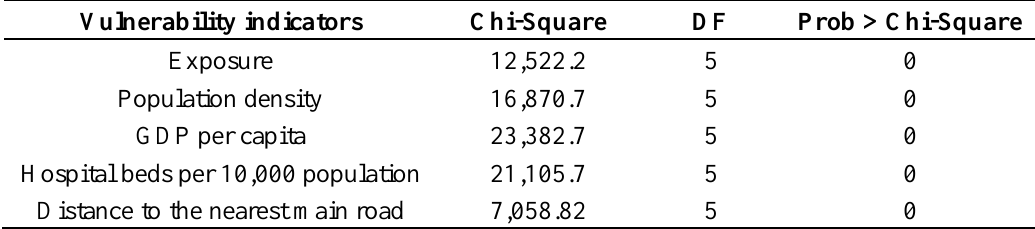
Table 1. Kruskal-Wallis one-way ANOVA of vulnerability indicators by six